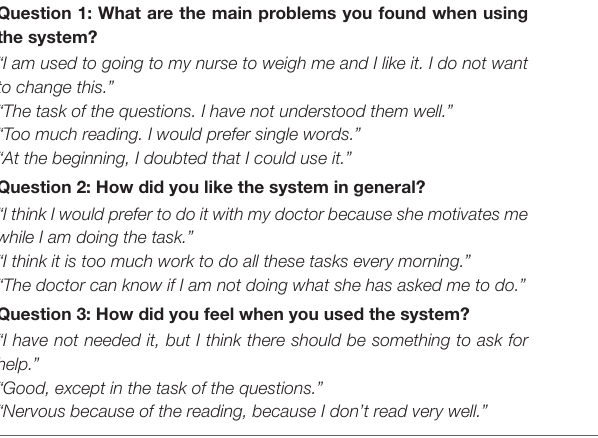
TABLE 6 | Negative answers to the acceptability open